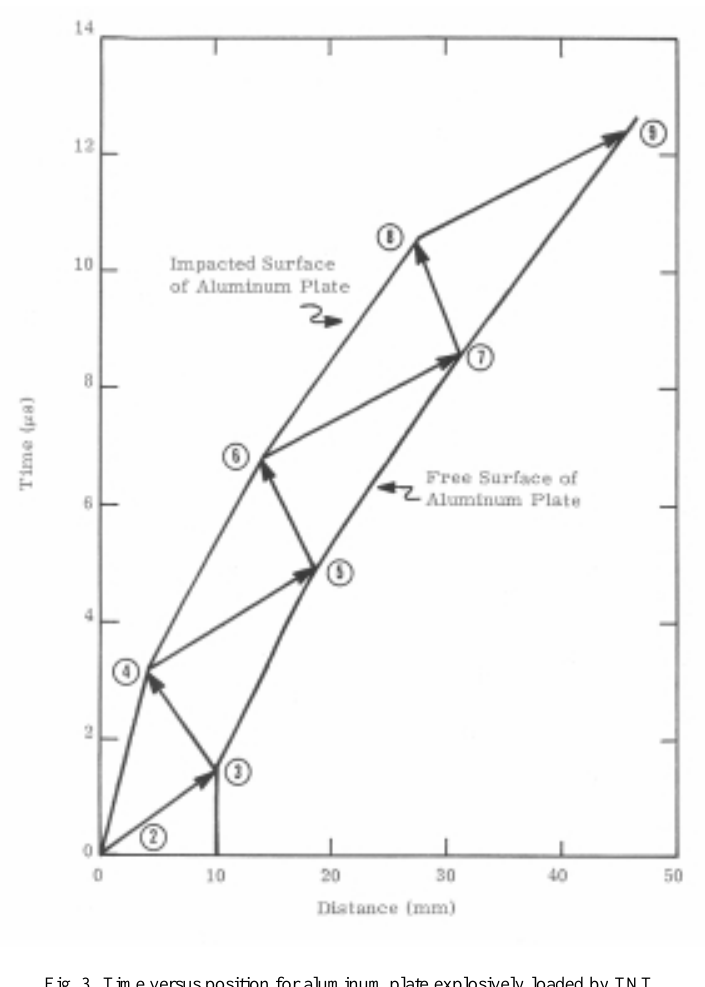
Fig. 3. Time versus position for aluminum plate explosively loaded by TNT.